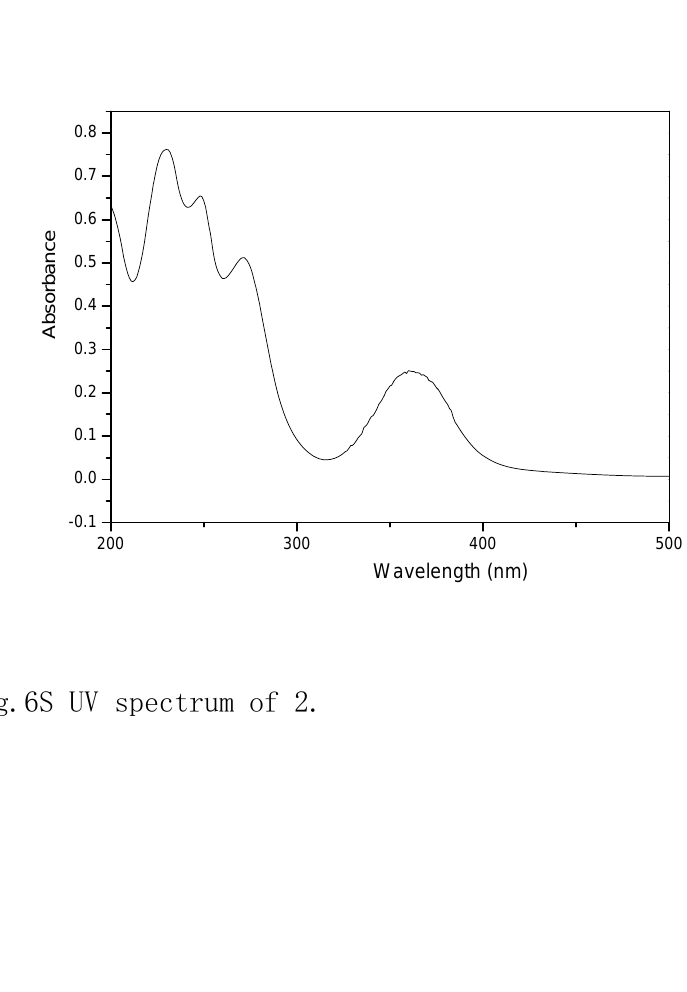
Fig.5S IR spectrum of 2.